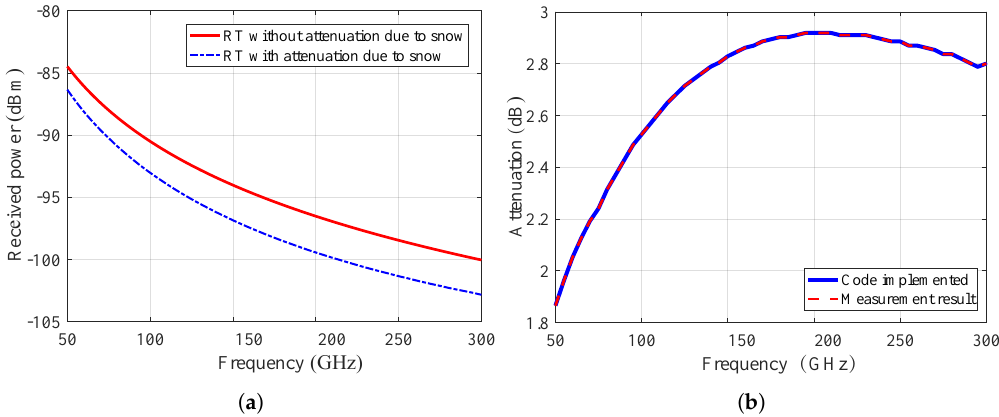
Figure 3. Validation of ray-tracing (RT) with attenuation caused by snow. ( a ) RT result vs. RT result with the attenuation caused by snow; ( b ) comparison between the measured attenuation magnitude (red dot curve) and post-processed RT results (blue curve).